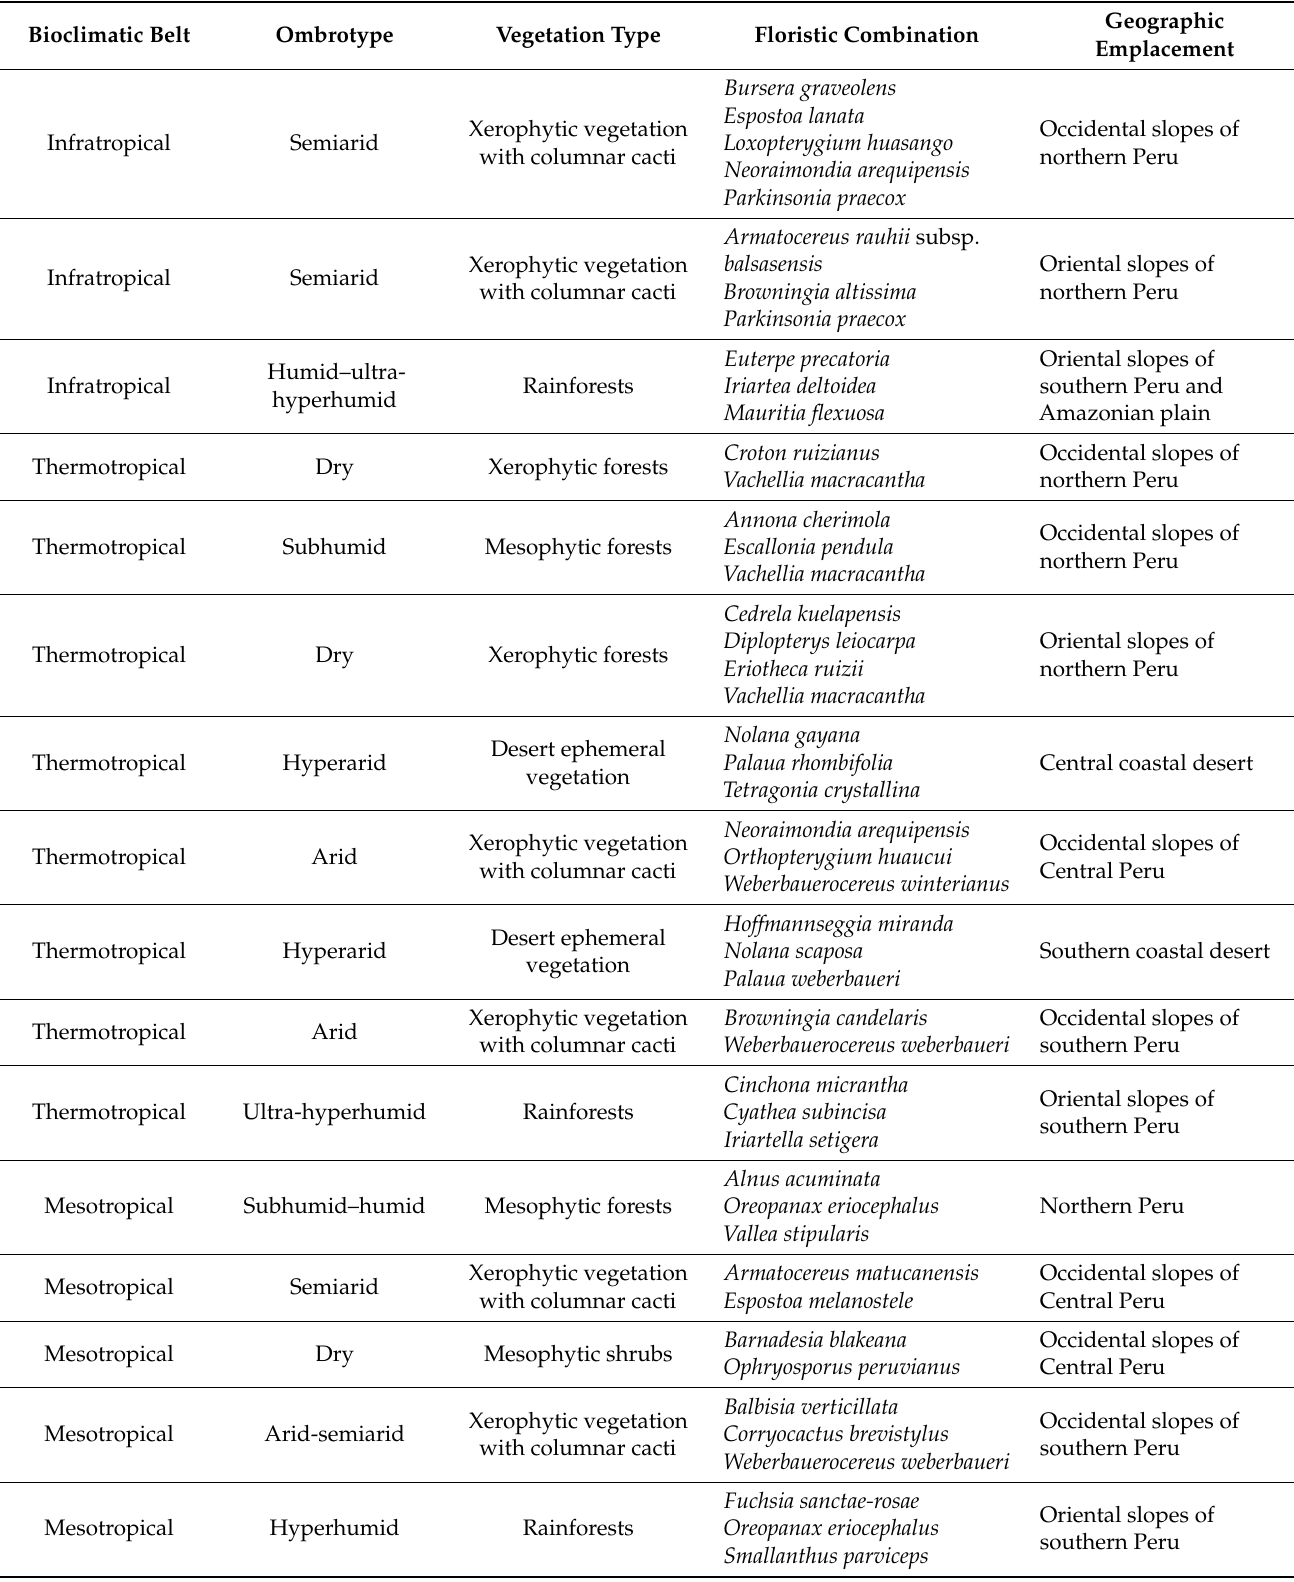
Table 1. Synthesis of Peruvian vegetation linked to bioclimatic belts and ombrotypes, based on Gal á n de Mera et al. [35,36]. Species names according to IPNI